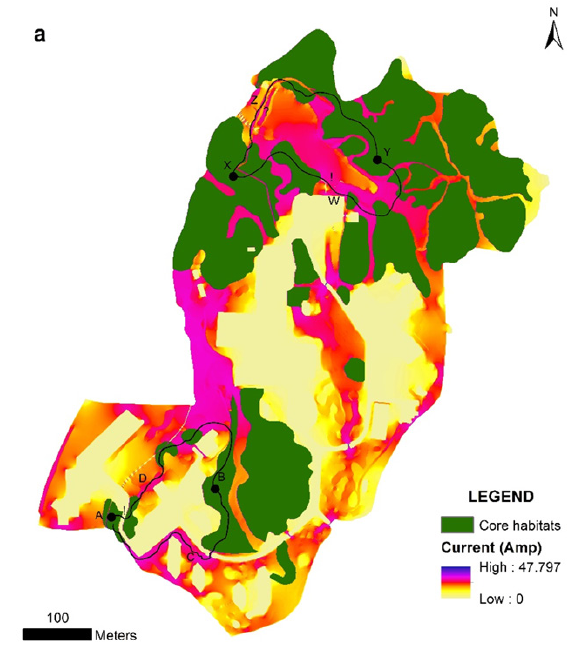
Figure 4. a) Current map of the study area indicating